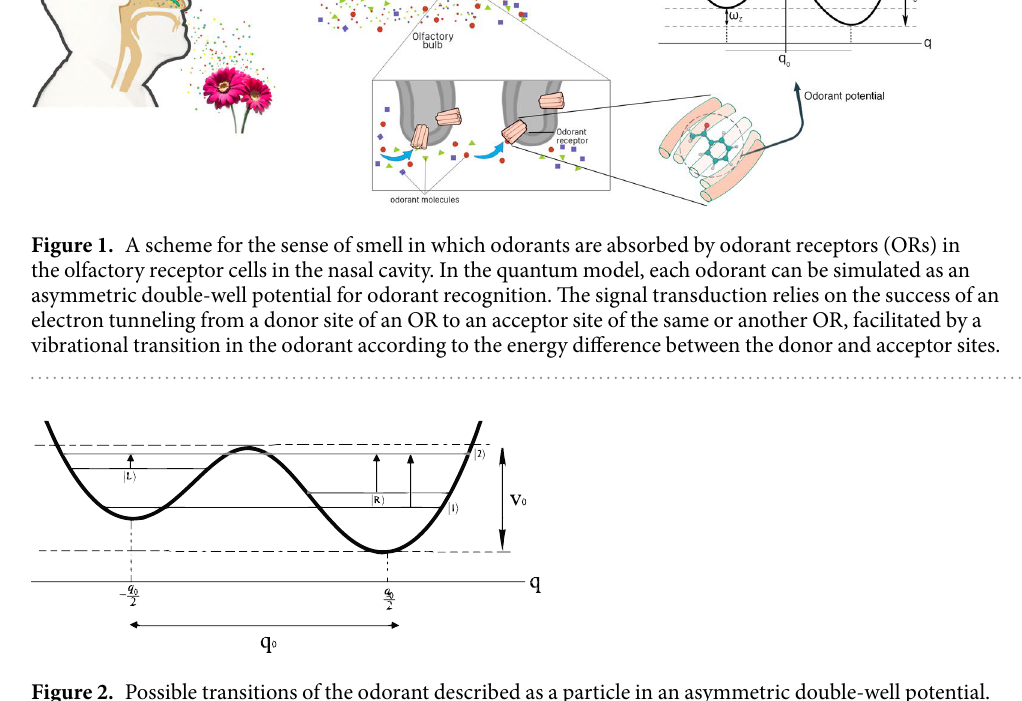
Figure 2. Possible transitions of the odorant described as a particle in an asymmetric double-well